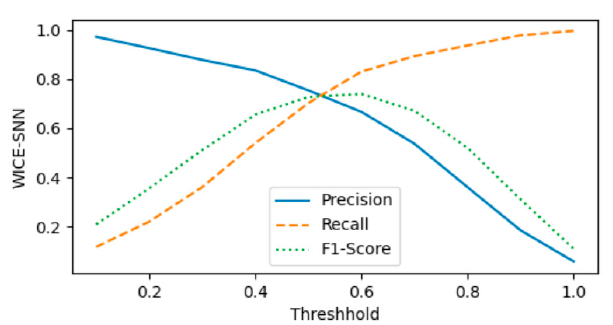
Figure A2. WICE-SNN Framework.